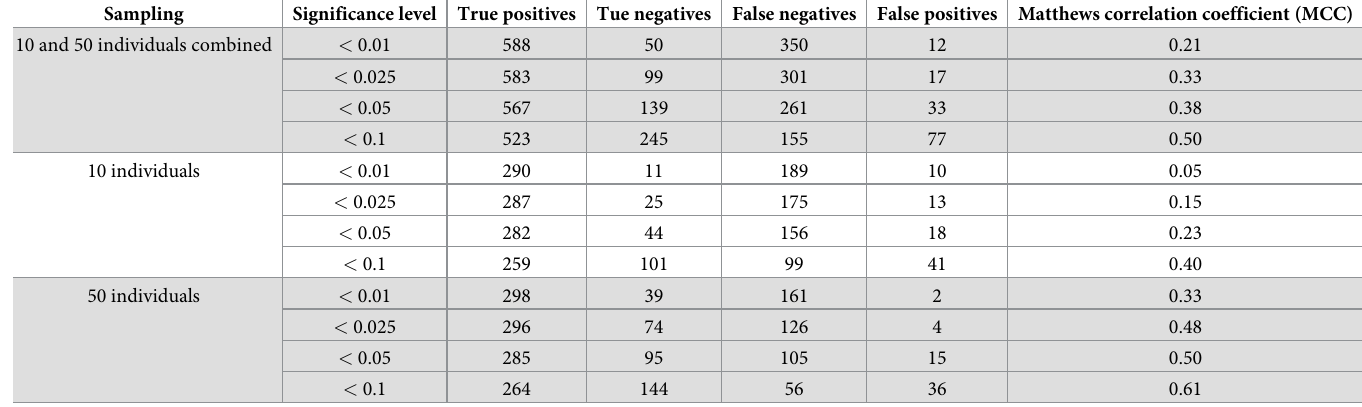
Table 1. Results of the mathews correlation coefficient for the simulated datasets. False positives represent datasets simulated under the Bayesian Skyline model prem- ises (i.e., constant, expansion, and bottleneck) that P2C2M.Skyline classified as a model violation. In contrast, false negatives represent datasets not simulated under Bayes- ian Skyline model premises (i.e., two-population models) that P2C2M.Skyline classified as not a model violation.